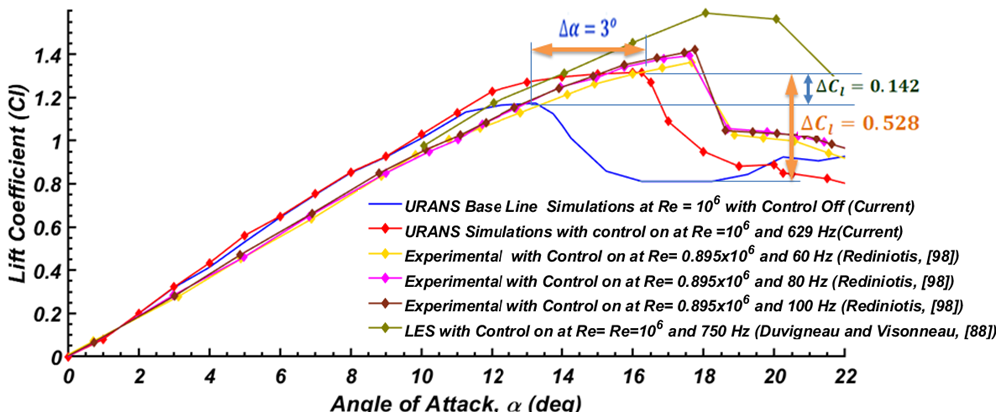
Figure 27. Airfoil lift coe ffi cient as a function of angle of attack at chord Re = 10 6 for control-o ff and control-on cases. Comparison with the earlier numerical results and experimental